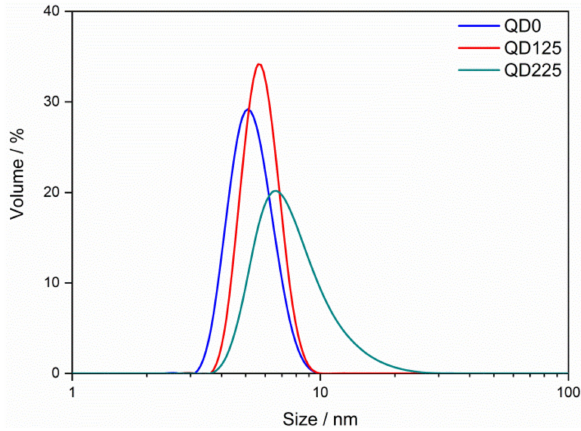
Figure 3. Size distributions of QD0, QD125, and QD225 samples in aqueous